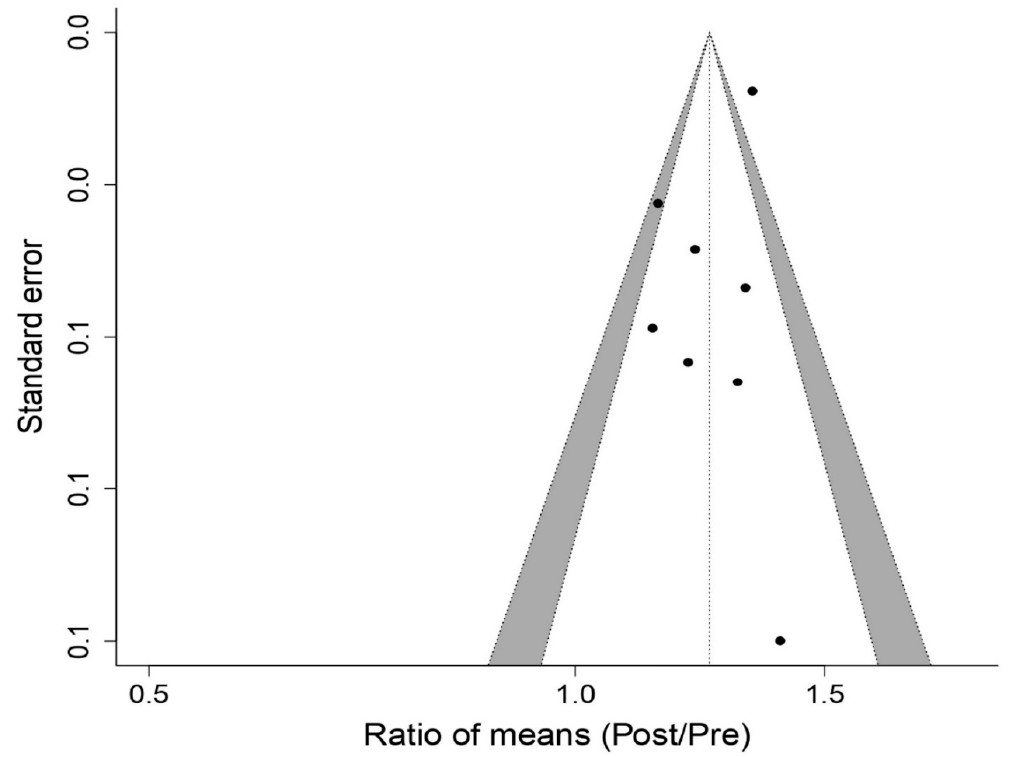
Figure 2. Forest Plot meta-analysis results for Maximal Pressure Inspiratory.